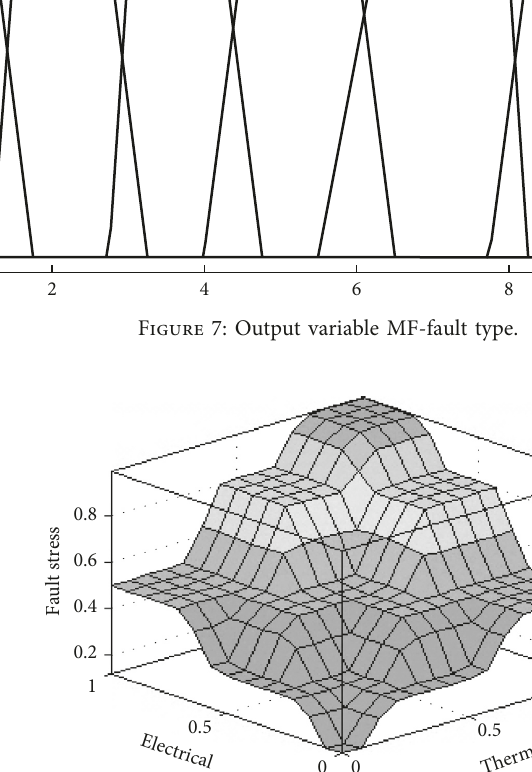
Figure 8: Overall fault stress surface